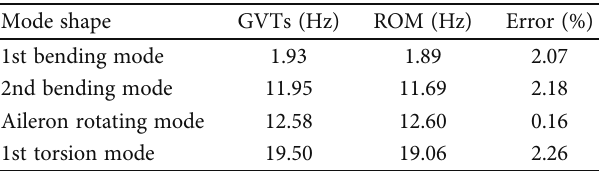
Aileron rotating